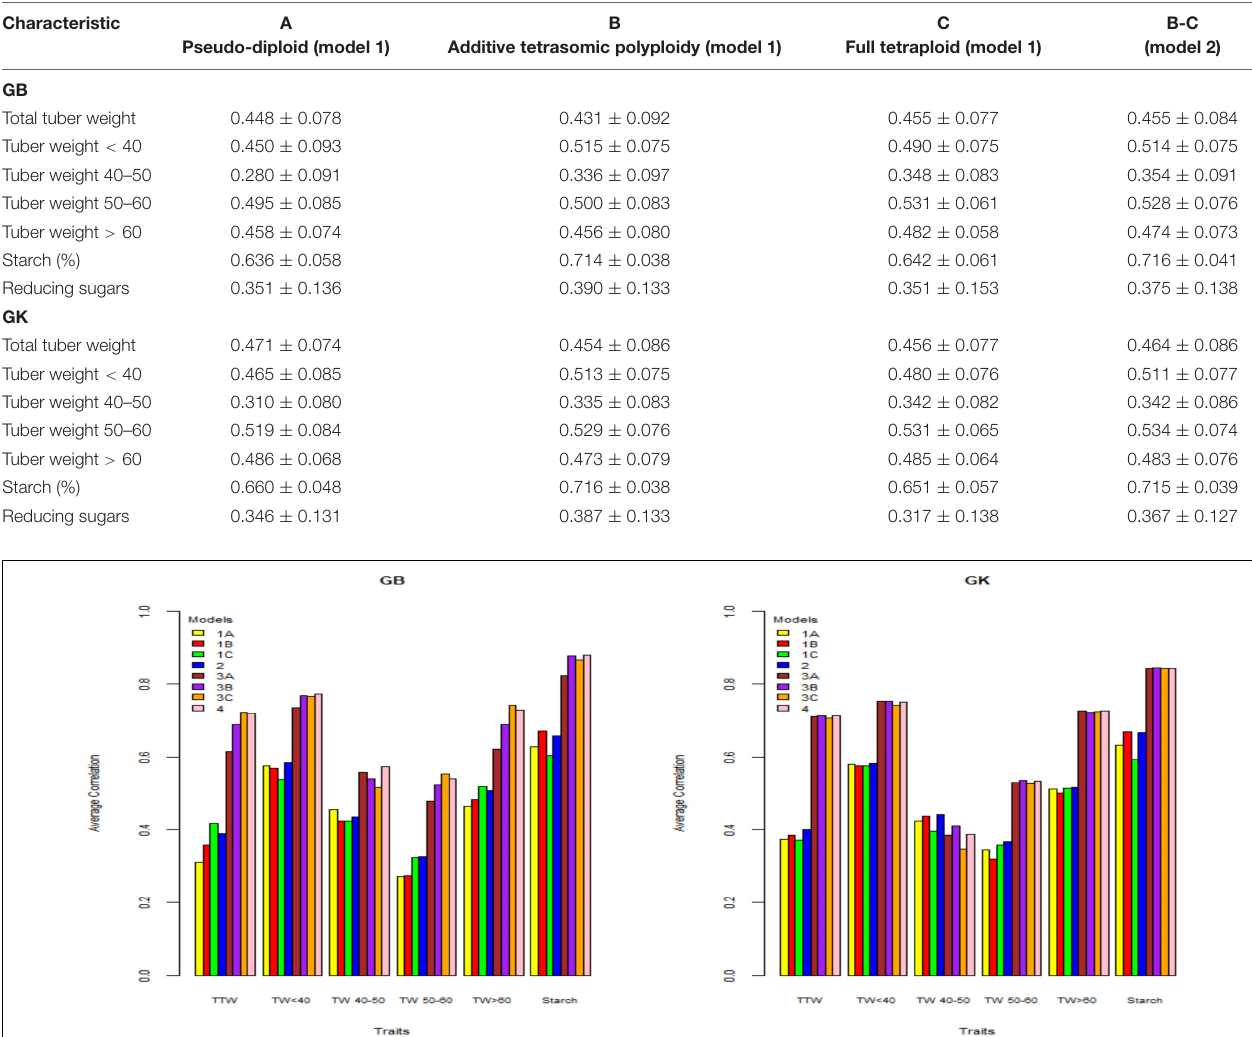
TABLE 4 | Single-environment genomic best linear unbiased predictor (GBLUP) (GB) and Gaussian kernel (GK) prediction accuracy ( ± standard deviation) for potato tuber characteristics considering pseudo-diploid (A) (model 1), additive tetrasomic polyploid (B) (model 1), full tetraploid (C) (model 1), and B-C (model 2) with 30 random partitions (70% training and 30% testing) in Umeå 2020 ( N = 252).